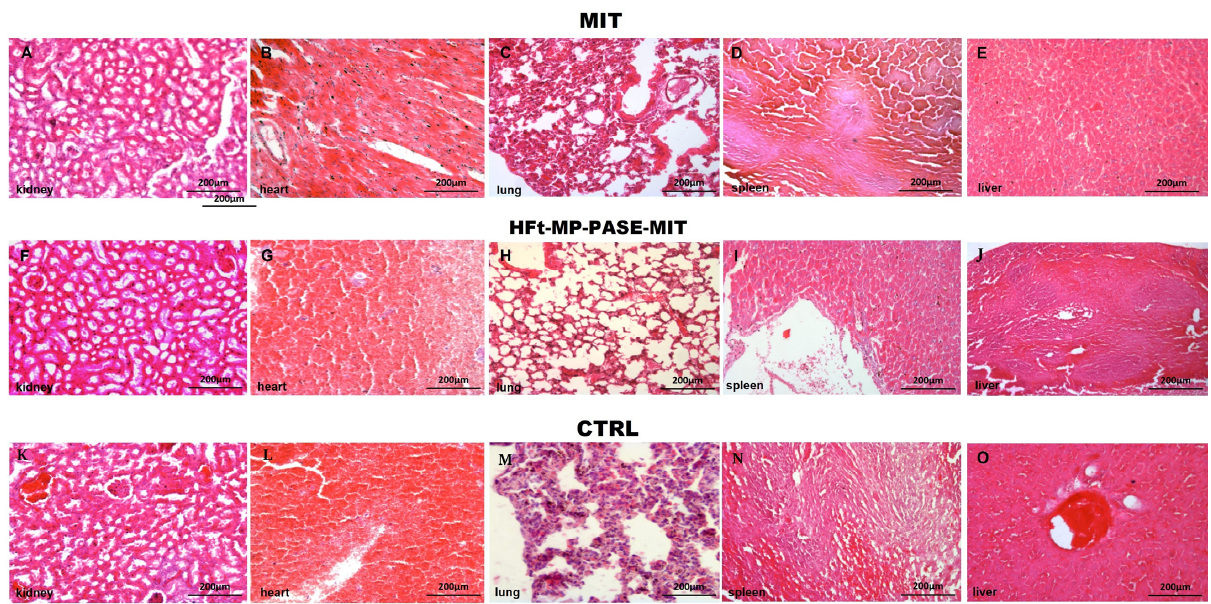
Figure 6. Histological evaluation of the integrity of the organs architecture. Several tissues as kidneys, hearth, lungs, spleen and liver were explanted from mice at sacrifice. The panel shows light microscope images from mice treated with MIT (images A – E ), HFt-MP-PASE-MIT (images F – L ) or saline (images M – Q ).